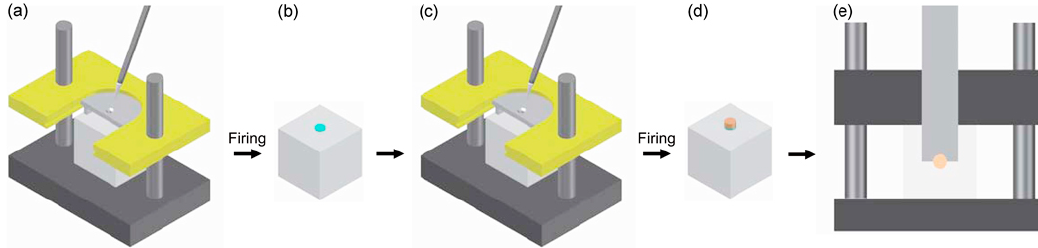
Figure 4. Fabrication process of the shear bond strength test specimen using Ultradent jig. ( a ) Application of a liner on an isolated zirconia surface; ( b ) Liner-coated zirconia specimen; ( c ) Application of veneering porcelain on the liner; ( d ) Veneered zirconia specimen; and ( e ) Shear bond strength testing in a universal testing machine. For group NL (no-liner), the veneering porcelain was directly applied onto the zirconia surface without the liner application and firing